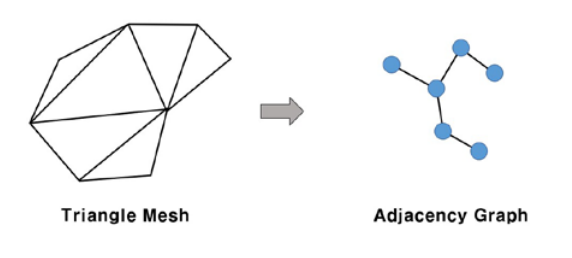
Figure 4. Construction adjacency graph from triangle